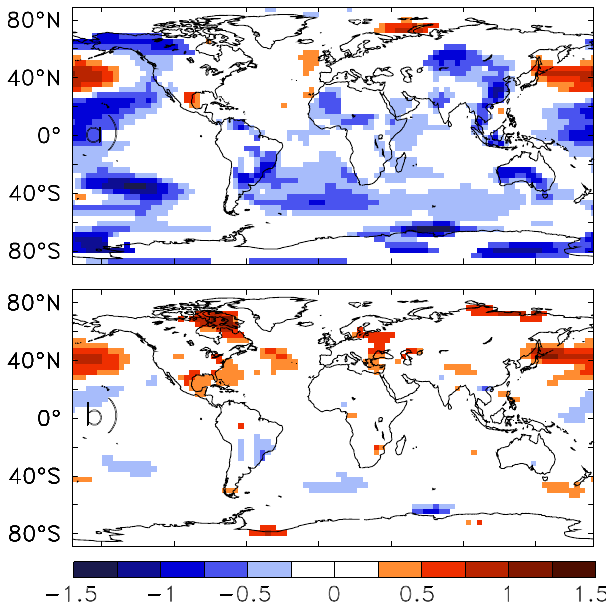
Fig. 8. Differences in annual mean temperature due to the net effect of vegetation dynamics (DYN – STAT) in (a) and caused by the bio- geophysical (DYN – STAT PS) in (b) . The differences are averaged over the period from the year 2270 until 2299. Shown differences are significant on a 95% level of significance.